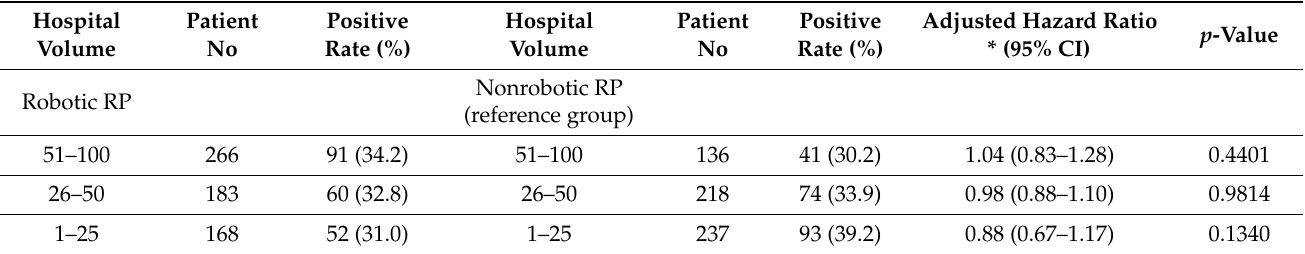
Table 5. Sensitivity analysis of multivariate analysis after propensity scores adjustment using Cox regression comparing biochemical failure rates stratified by hospital volume between nonrobotic and robotic radical prostatectomy.